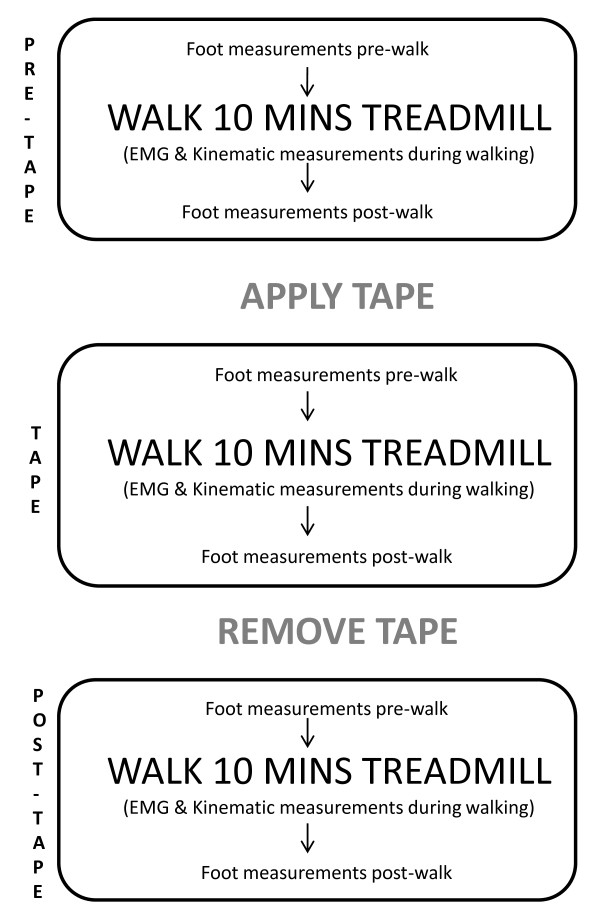
Experimental procedure.